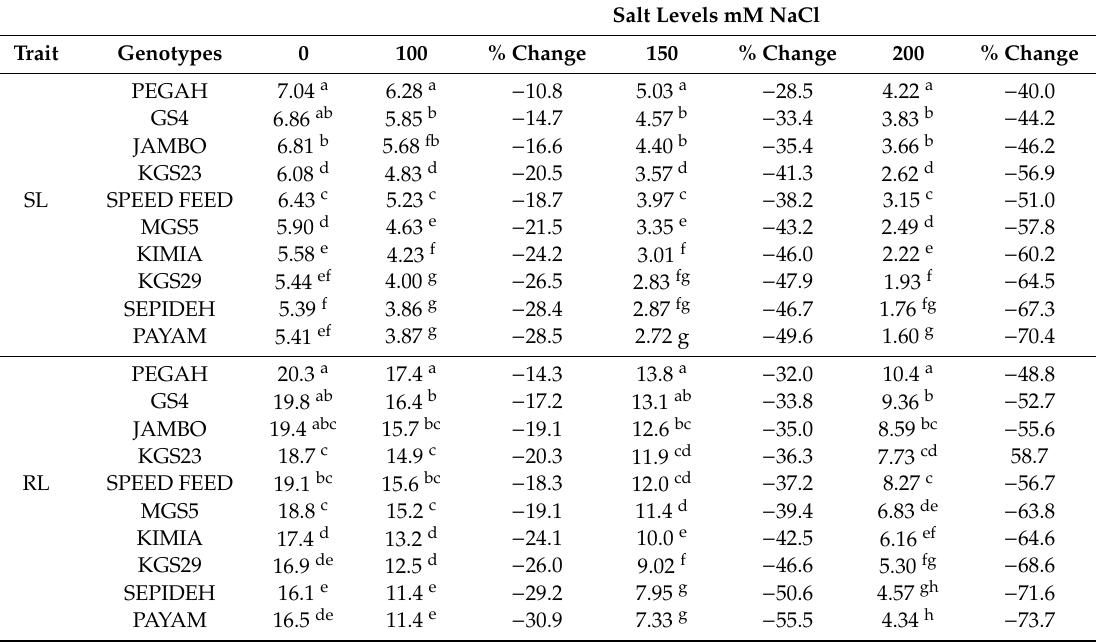
Table 3. Seedling growth parameters of ten sorghum genotypes in four salt treatments (means).